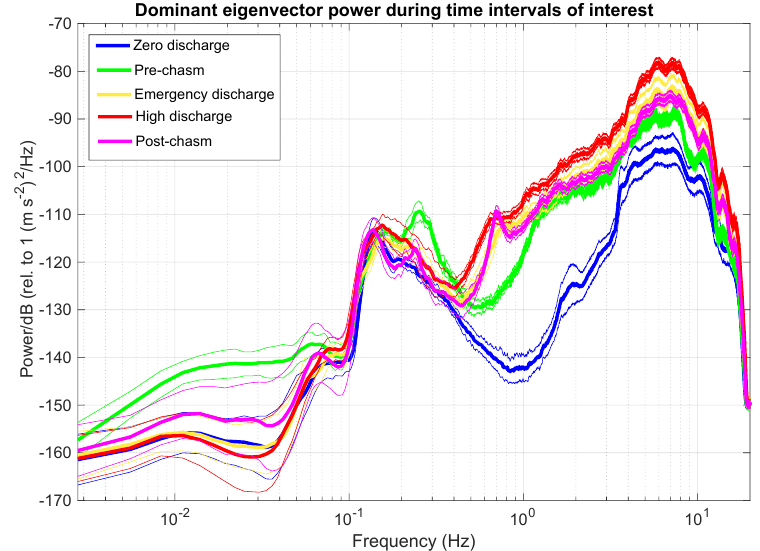
Figure 4. Power spectral density observed for each of the five studied intervals, shown with one standard deviation error bars. There is a significant increase (up to 30dB) in the average power of the dominant eigenvector during the four time intervals with discharge, particularly between 0.5 and 12Hz. The power during three time intervals following spillway damage exceeds the “Pre-chasm” at frequencies above 0.5Hz. Table 1. Coefficients, exponents, and uncertainty for power functions fit by least-square regression (shown in Fig. 6). Time interval Logarithm of 95% Confidence Exponent 95% Confidence coefficient (base 10) intervals intervals Lower Upper Lower Upper bound bound bound bound 2017 Pre-Crisis − 18.055